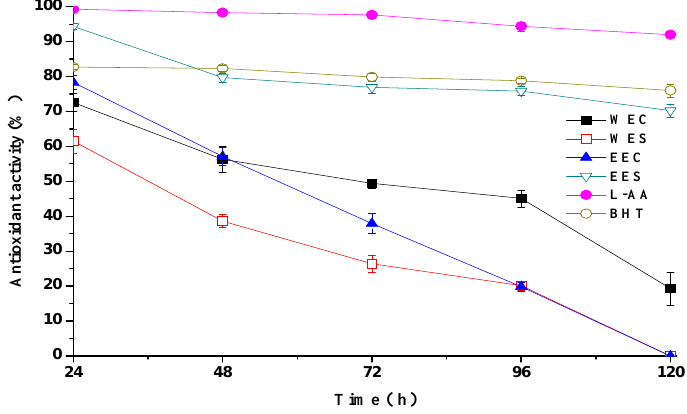
Each value is expressed as mean ± S.D. (n = 3).